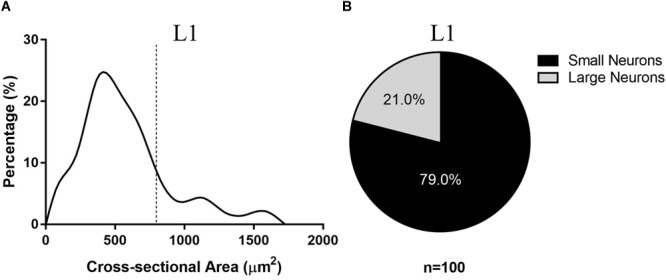
Cross-sectional areas of DiI-labeled cells in rat DRGs. (A) The cross-sectional areas of 100 labeled neurons, which were randomly selected from the L1 DRGs of six rats, are plotted against the number of cells observed in each 50 μm2 bin to determine the distribution of cross-sectional areas of the neurons. (B) Of the 100 labeled neurons, 79% were between 100 and 800 μm2.